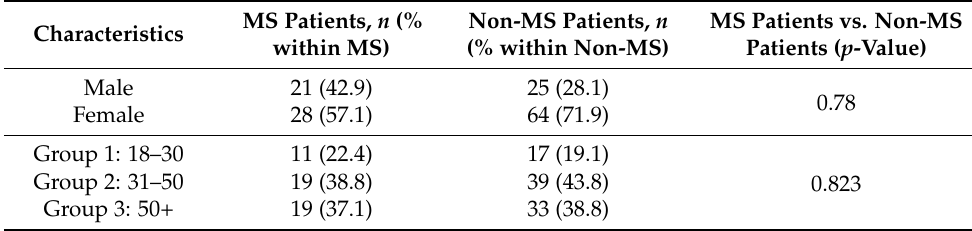
Table 1. Characteristics of the patients included in the study.